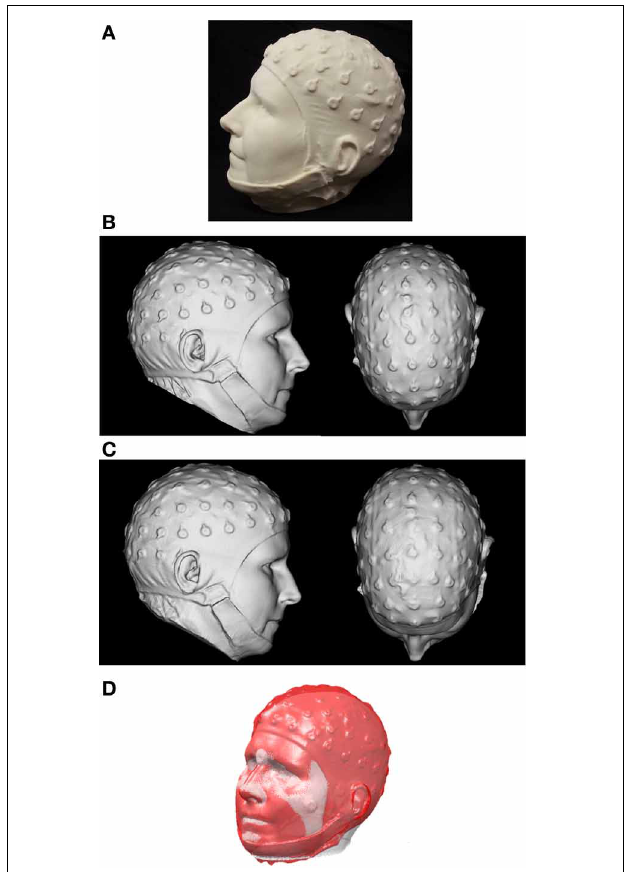
FIGURE 1 | (A) The 3D-printed replica head, created from first scan with the FaceSCAN 3D sensor of a real human subject wearing an EEG cap (B) 3D mesh of the printed model acquired with the FaceSCAN 3D sensor from which a “ground truth” coordinate list of electrode positions was generated. (C) 3D mesh of the printed model acquired with the FlyTri sensor. (D) Registration of EEG electrode positions from the 3D FlyTri model to structural MRI. The gray surface is generated from the segmented MRI and the red surface is generated from the FlyTri scan of the printed